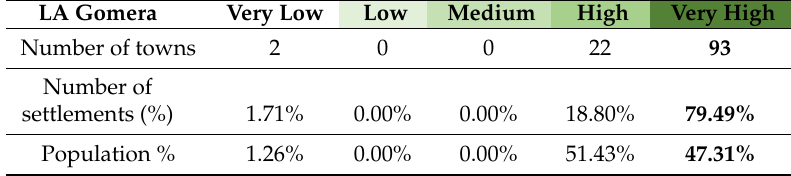
Table 6. Outcomes regarding the demographic dynamics and urban agglomerations classified according to the accessibility levels in the Island of La Gomera (Source: